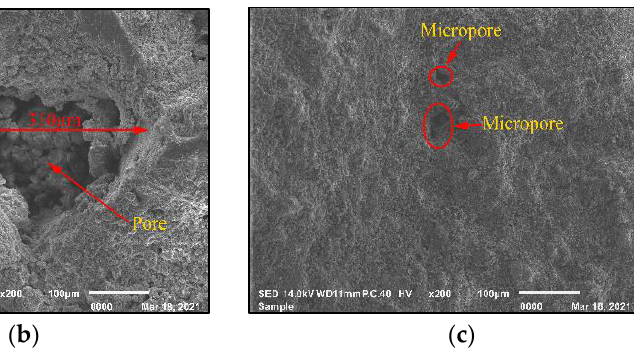
NFA Figure 4. X-ray diffraction diagrams of fine aggregate. 2.3. Mix Proportions In this study, RFA1 and RFA2 were used to replace NFA with different replacement ratios (25%, 50%, 75% and 100%) to prepare recycled aggregate thermal insulation concrete, namely RATIC1 and RATIC2. Considering the influence of GHBs and RFAs on the shrink- age performance of concrete, a group of NAC and a group of TIC specimens were designed as the control groups. Mix proportions of different types of concrete are shown in Table 5.